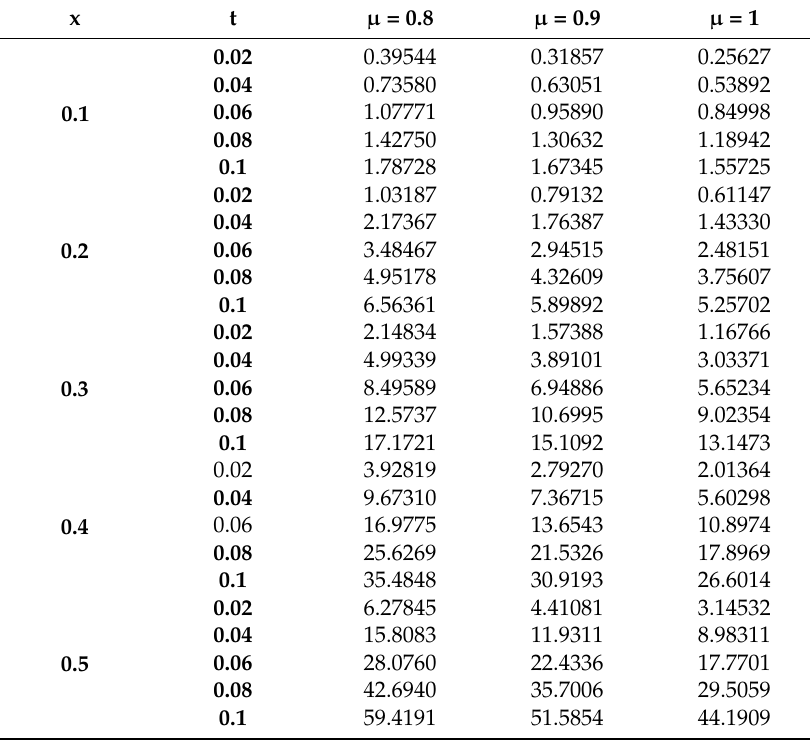
Figure 8. (cid:125) -curves obtained for v ( x , t ) in case ( iii ) with diverse µ when x = 0.1 and t = 0.01 at Figure 8 . ℏ -curves obtained for 𝑣(𝑥, 𝑡) in case (𝑖𝑖𝑖) with diverse 𝜇 when 𝑥 = 0.1 and 𝑡 = 0.01 at distinct n distinct 𝑛 .